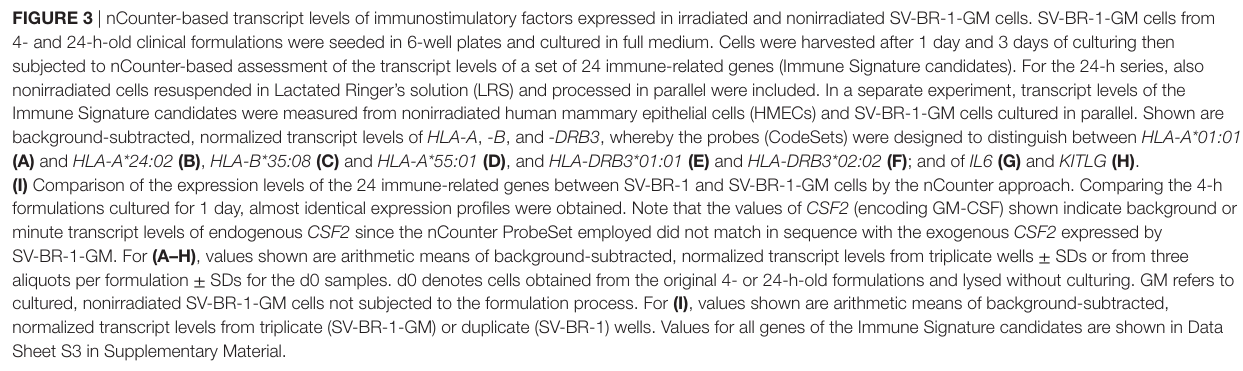
FigUre 3 | nCounter-based transcript levels of immunostimulatory factors expressed in irradiated and nonirradiated SV-BR-1-GM cells. SV-BR-1-GM cells from 4- and 24-h-old clinical formulations were seeded in 6-well plates and cultured in full medium. Cells were harvested after 1 day and 3 days of culturing then subjected to nCounter-based assessment of the transcript levels of a set of 24 immune-related genes (Immune Signature candidates). For the 24-h series, also nonirradiated cells resuspended in Lactated Ringer’s solution (LRS) and processed in parallel were included. In a separate experiment, transcript levels of the Immune Signature candidates were measured from nonirradiated human mammary epithelial cells (HMECs) and SV-BR-1-GM cells cultured in parallel. Shown are background-subtracted, normalized transcript levels of HLA-A , -B , and -DRB3 , whereby the probes (CodeSets) were designed to distinguish between HLA-A*01:01 (a) and HLA-A*24:02 (B) , HLA-B*35:08 (c) and HLA-A*55:01 (D) , and HLA-DRB3*01:01 (e) and HLA-DRB3*02:02 (F) ; and of IL6 (g) and KITLG (h) . (i) Comparison of the expression levels of the 24 immune-related genes between SV-BR-1 and SV-BR-1-GM cells by the nCounter approach. Comparing the 4-h formulations cultured for 1 day, almost identical expression profiles were obtained. Note that the values of CSF2 (encoding GM-CSF) shown indicate background or minute transcript levels of endogenous CSF2 since the nCounter ProbeSet employed did not match in sequence with the exogenous CSF2 expressed by SV-BR-1-GM. For (a–h) , values shown are arithmetic means of background-subtracted, normalized transcript levels from triplicate wells ± SDs or from three aliquots per formulation ± SDs for the d0 samples. d0 denotes cells obtained from the original 4- or 24-h-old formulations and lysed without culturing. GM refers to cultured, nonirradiated SV-BR-1-GM cells not subjected to the formulation process. For (i) , values shown are arithmetic means of background-subtracted, normalized transcript levels from triplicate (SV-BR-1-GM) or duplicate (SV-BR-1) wells. Values for all genes of the Immune Signature candidates are shown in Data Sheet S3 in Supplementary